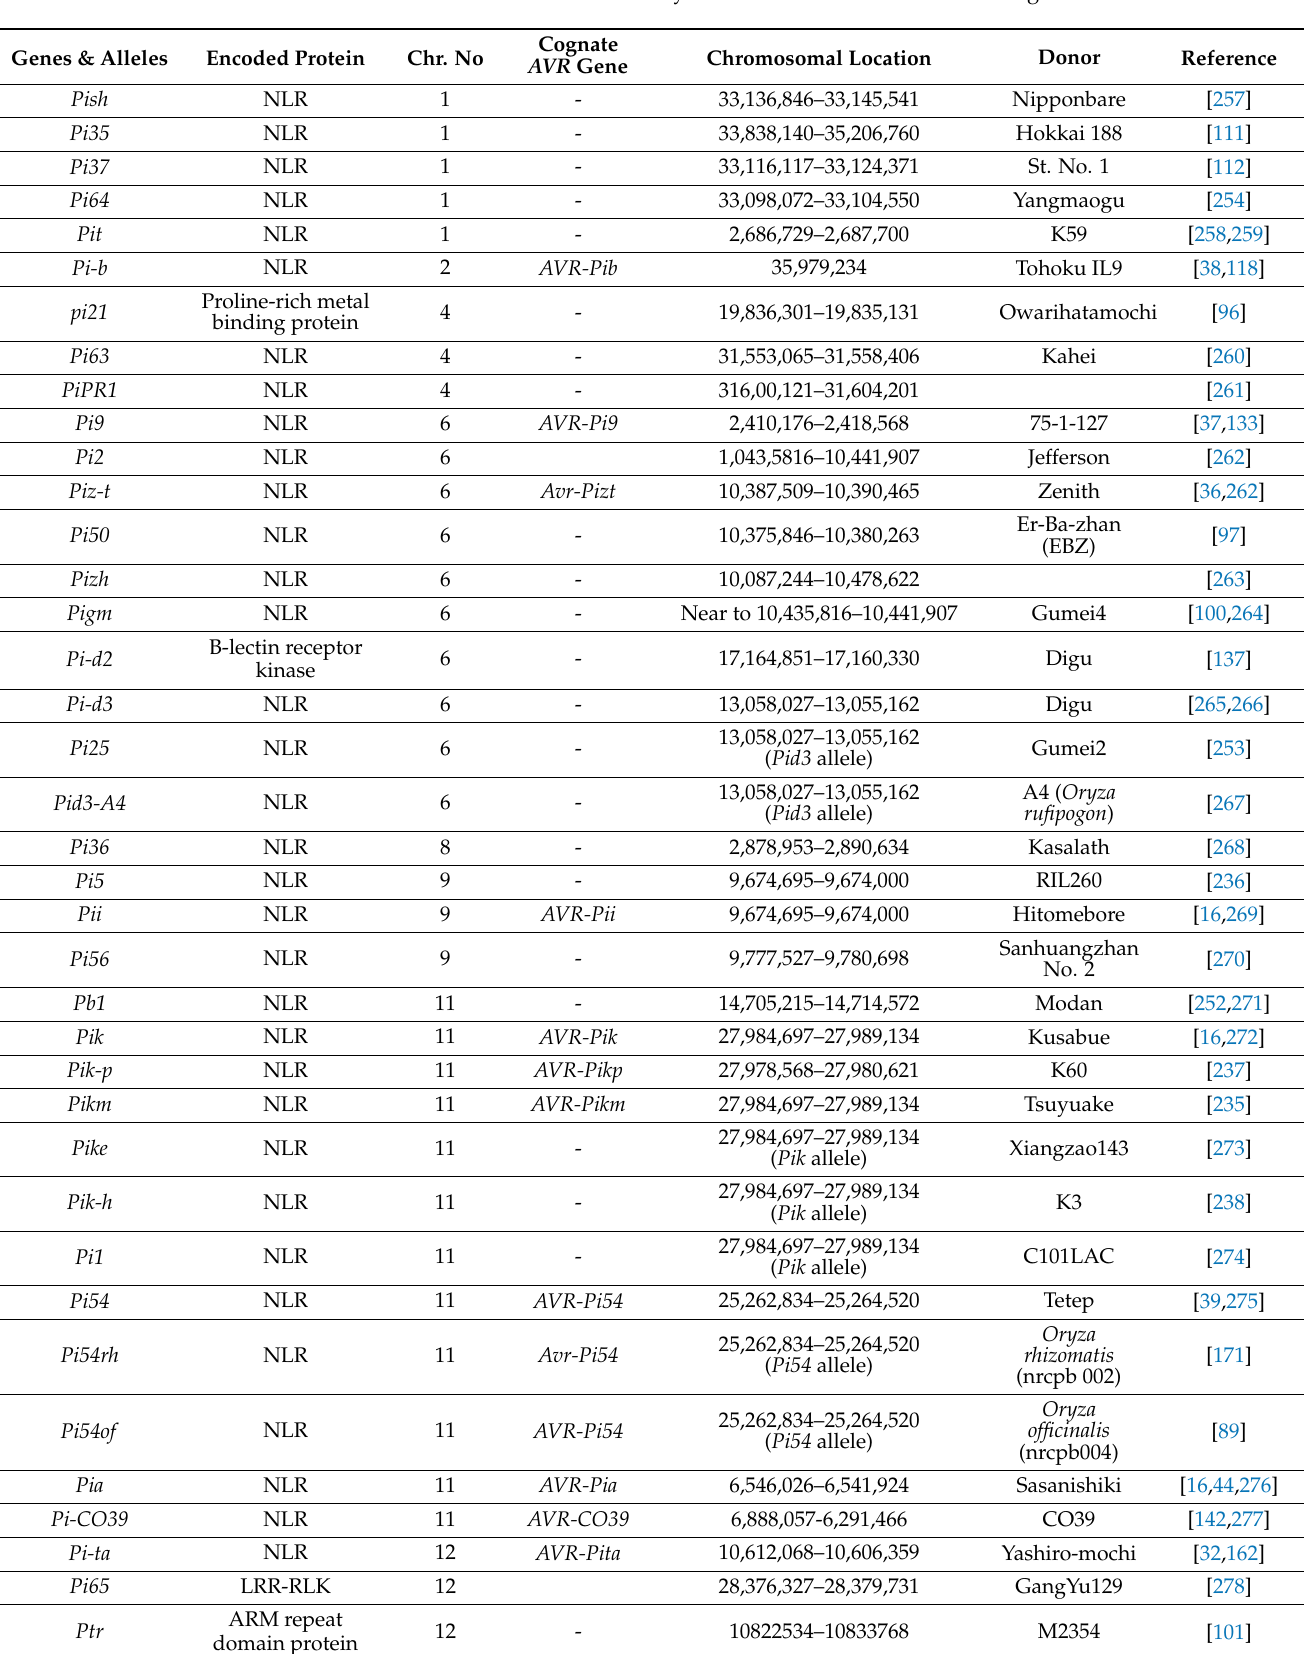
Table 4. The cloned and functionally characterized rice blast resistance